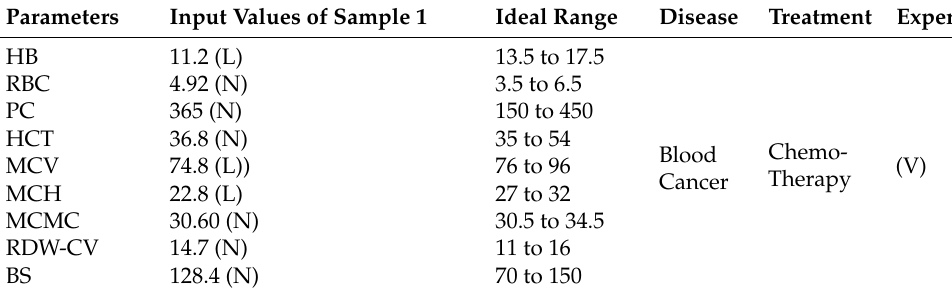
Table 6. Sample 4 and its